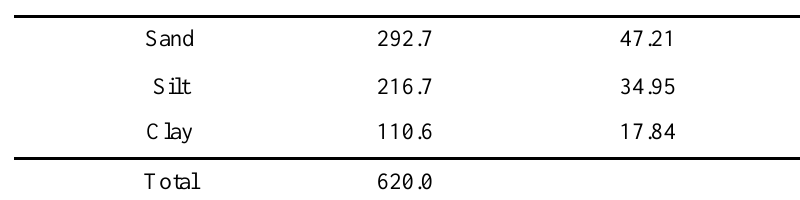
Constituents of soil